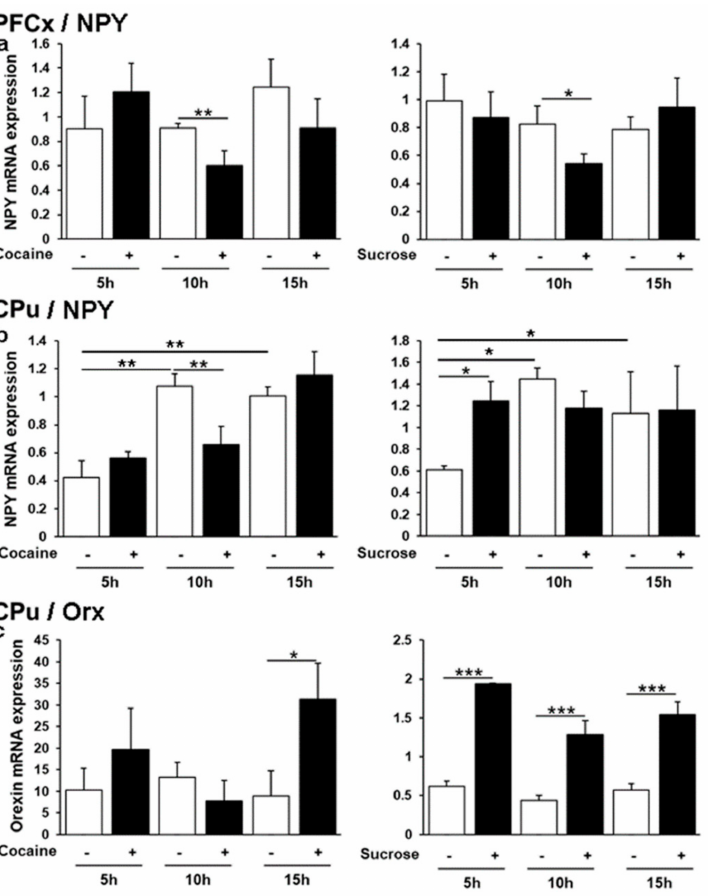
Figure 7. NPY and orexin neuropeptides mRNA levels in the PFCx and the CPu. Relative expression of mRNAs was analyzed( a–c ), as described in legend to Figure 2. * p < 0.01, ** p < 0.01, *** p <